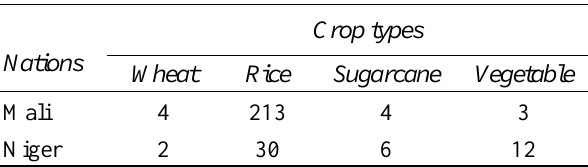
Table 2.3: The size of irrigated area - Irrigated crop areas in West Africa (thousand hectares)